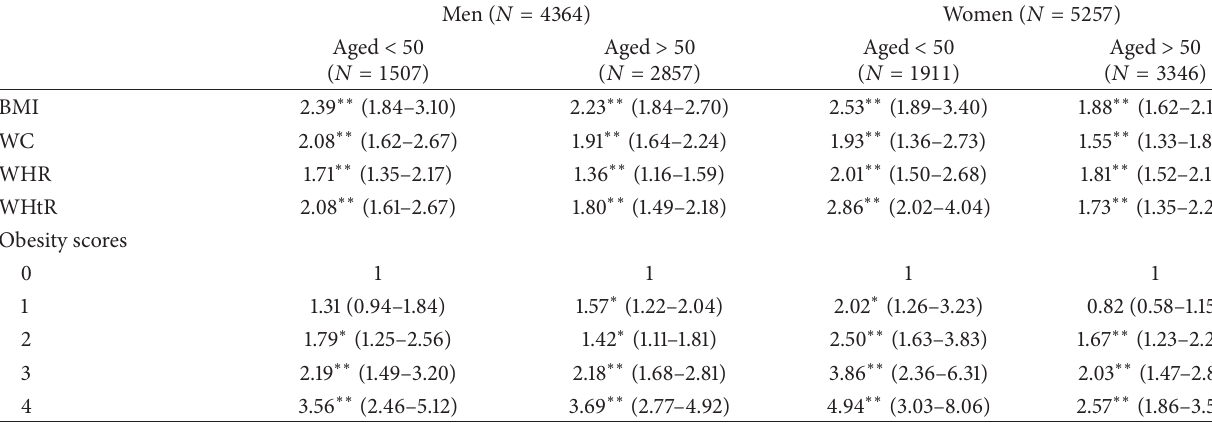
Table 3: Obesity using anthropometric indices correlated to the risk (odds ratio) of hypertension, adjusted for education levels and race across gender and age groups, using multivariate logistic